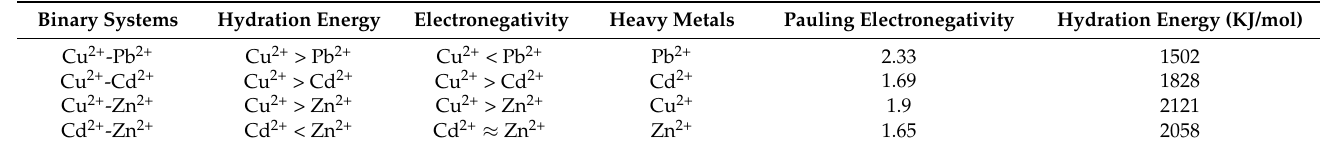
Table 3. The orders of hydration energy and electronegativity of the heavy metals in different binary systems. Binary Systems Hydration